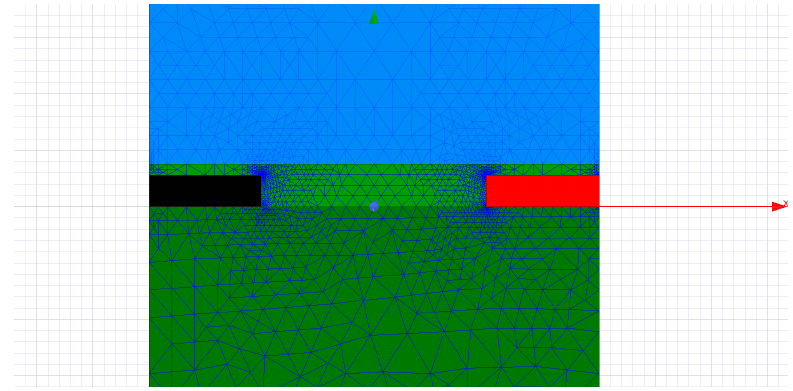
Figure 7. Meshing in ANSYS 2D Extractor of a section in the traces of the capacitive sensor.